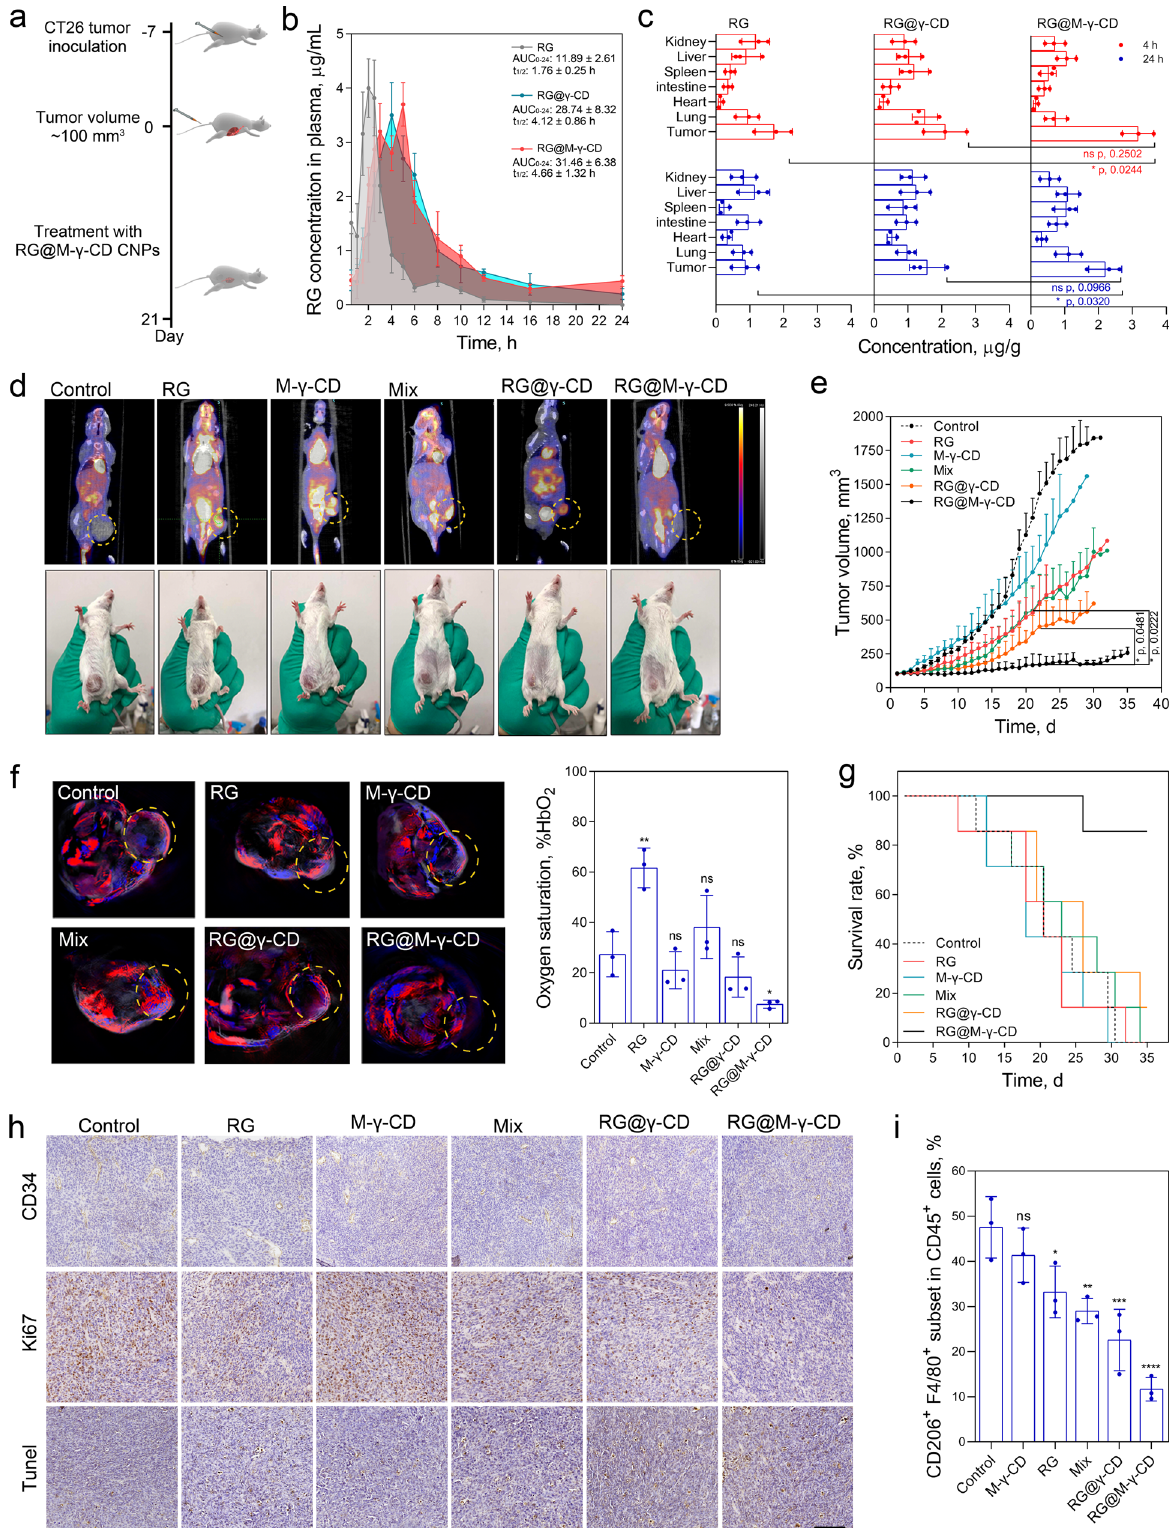
mannose-mediated targeting strategy further potentiated tumor accumulation of RG@M- γ -CD CNPs. Based on the pharmacokinetic and targeting advantages, we implemented the strategy into treatment of CT26 tumor (~100 mm 3 ). CT26 tumor-bearing mice were randomly divided Supplementary Fig. 43). Multispectral optoacoustic